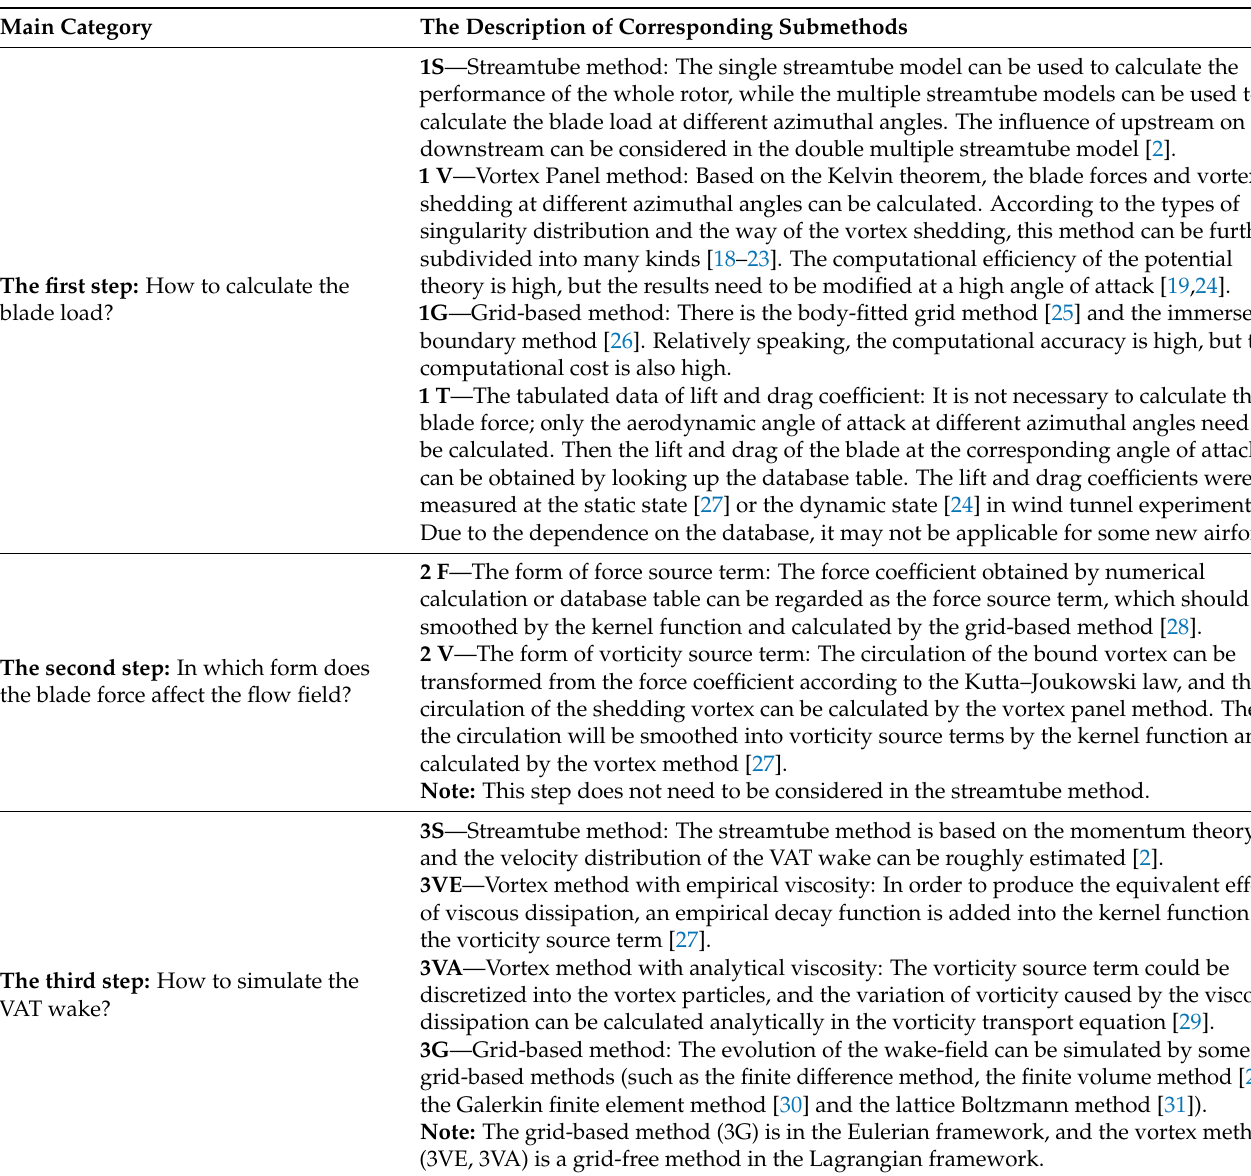
Table 1. Three steps of the wake simulation and the corresponding sub methods (Note: there is a label in bold before the method, which is the abbreviation of the method and will be used in the following analysis. The number of the label is the step of this process; the letter of the label is the initial of this